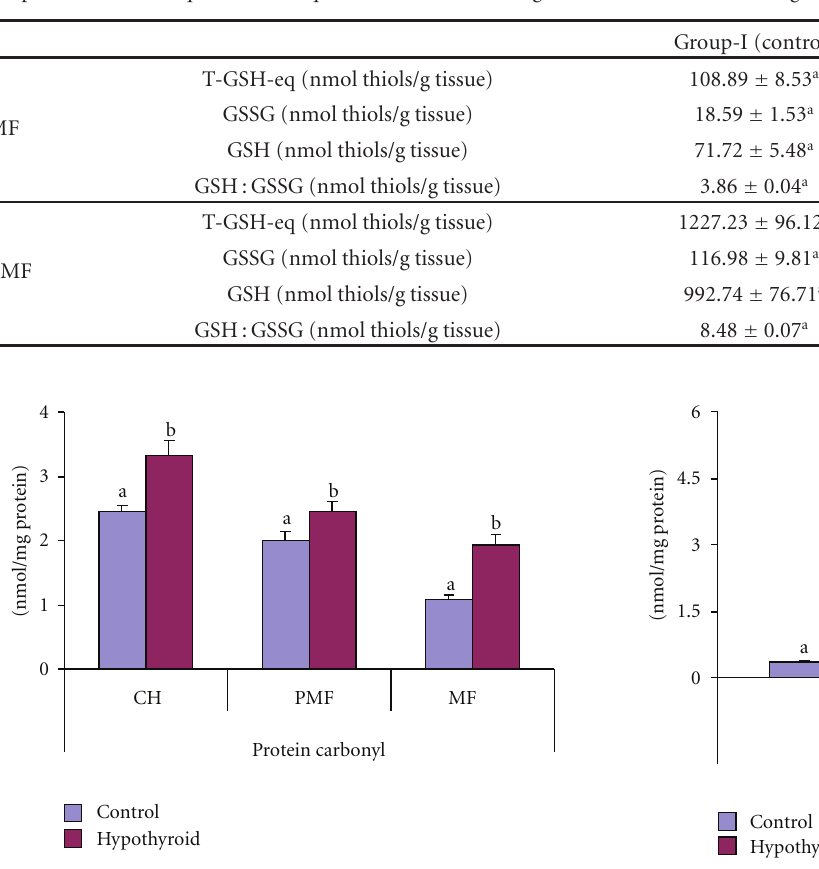
Figure 3: E ff ect of neonatal PTU treatment on hydrogen peroxide (H 2 O 2 ; nmol/mg protein) in postmitochondrial fraction (PMF) and mitochondrial fraction (MF) of testes of rats. Data are ex- pressed as mean ± S.D. of 5 observations and subjected to unpaired Student’s t -test. Statistical significance was accepted at P < 0 . 05. at P < 0 . 05 as represented by superscripts of di ff erent